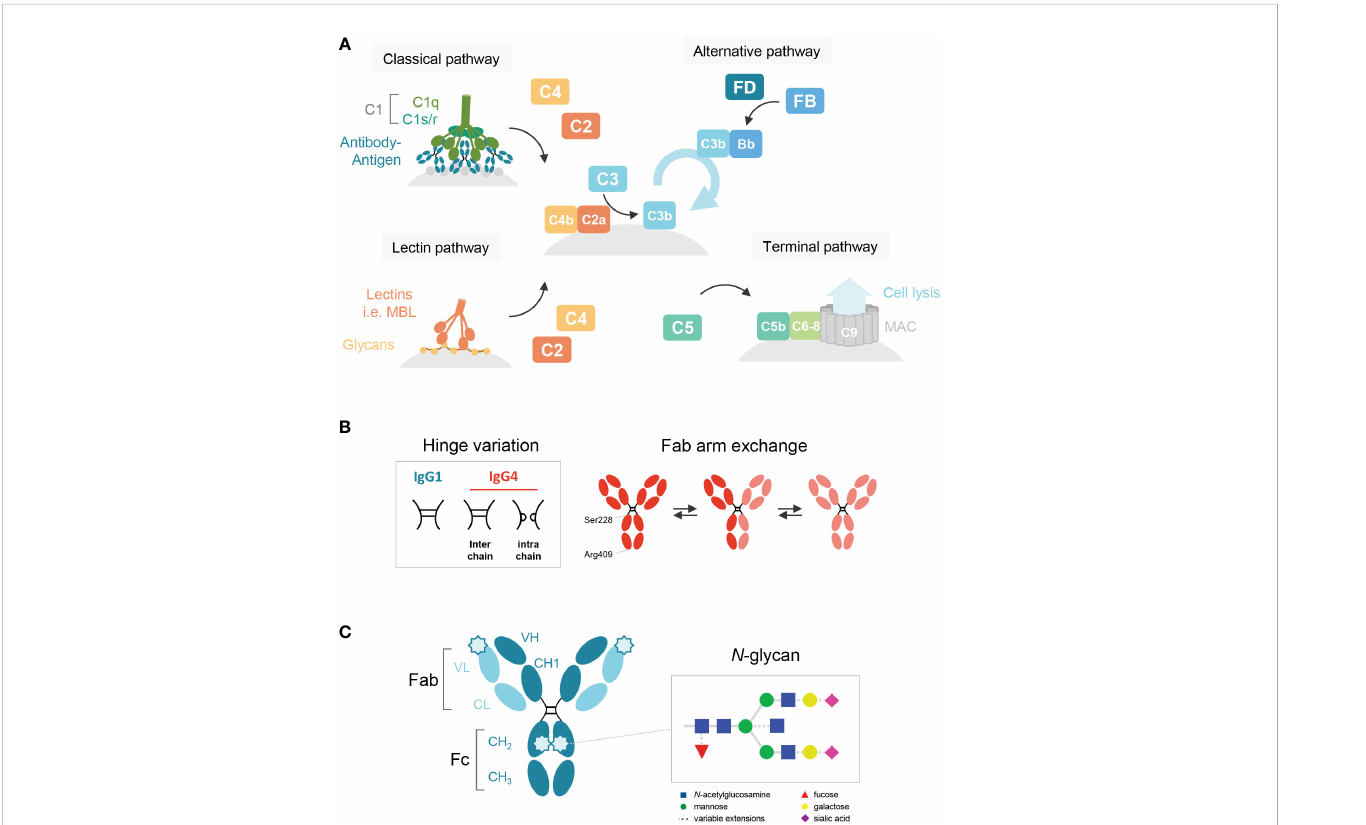
FIGURE 1 Schematic overview of the human IgG antibody structure and antibody-mediated complement activation. (A) Generalized overview of the complement system, which is activated through three pathways: the classical, lectin and alternative pathway. The classical pathway is activated by binding of C1q to antigen-bound IgM and IgG, which then forms the C1 complex with its proteases C1r/s. The lectin pathway is activated by the binding of lectins, such as mannose-binding lectin (MBL), to carbohydrates on cell surfaces. C3b deposition induced by these pathways or spontaneous hydrolysis of C3 can activate the alternative pathway, mediated by Factor B and D, which results in an ampli fi cation loop of C3b deposition. C3b can opsonize the target cell for phagocytosis and can lead to the assembly of the membrane attack complex with factors C5b to C9 through the terminal pathway and subsequent cell lysis. (B) A structural representation of the hinge variation and half molecule exchange of IgG4 via switch of inter-chain to intra-chain disul fi de bonds at amino acid positions 228 and 409. (C) General structure of an IgG monomer and schematic representation of N -linked glycan composition of human IgG Abs. The glycans are attached to asparagine (N) at position 297 in the C H 2 domain and have a biantennary heptasaccharide core (solid line) and variable extensions (dash line), such as fucose, galactose and/or sialic acid. Novel glycosylation sites can be introduced within the Fab region of matured